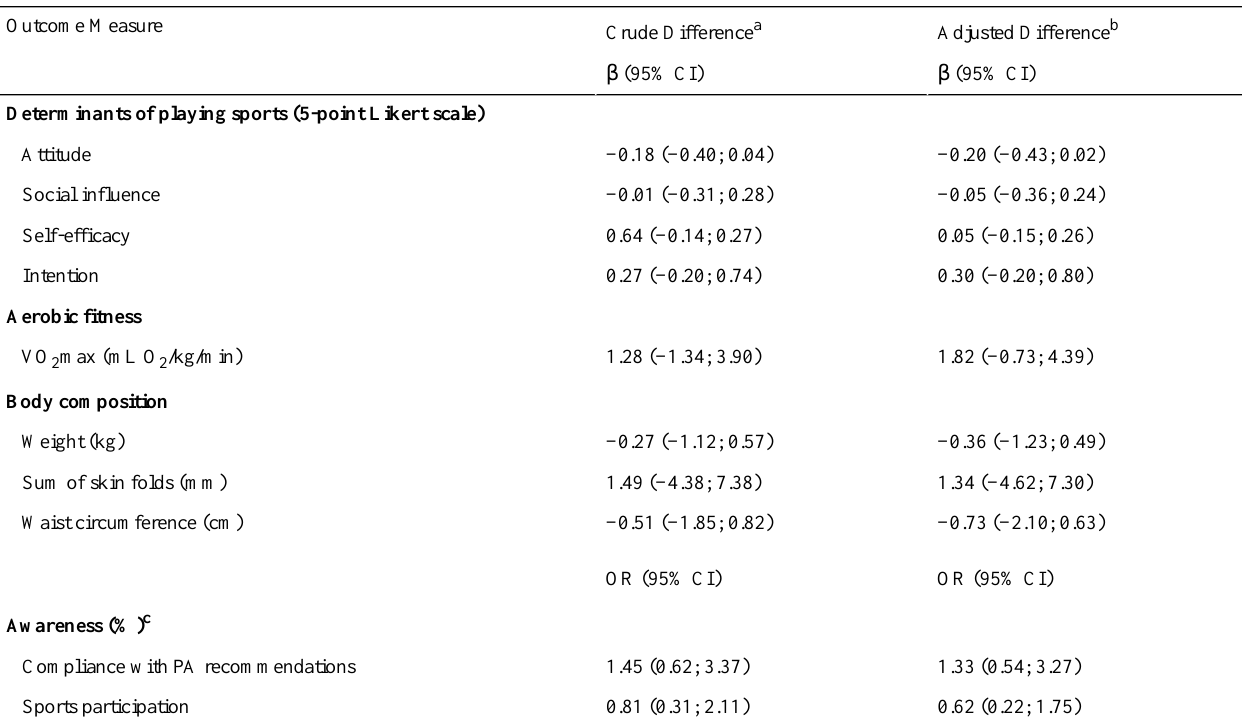
Table 4. Effectiveness of the 3-month PAM intervention on determinants of PA, aerobic fitness, and body composition: results of regression